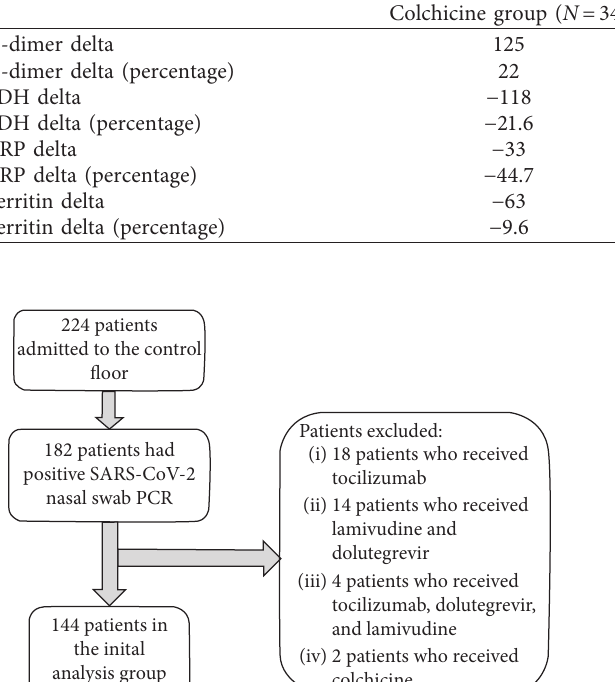
Table 5. Similar to the initial analysis, patients who received colchicine had a lower rate of intubation (47.1% versus